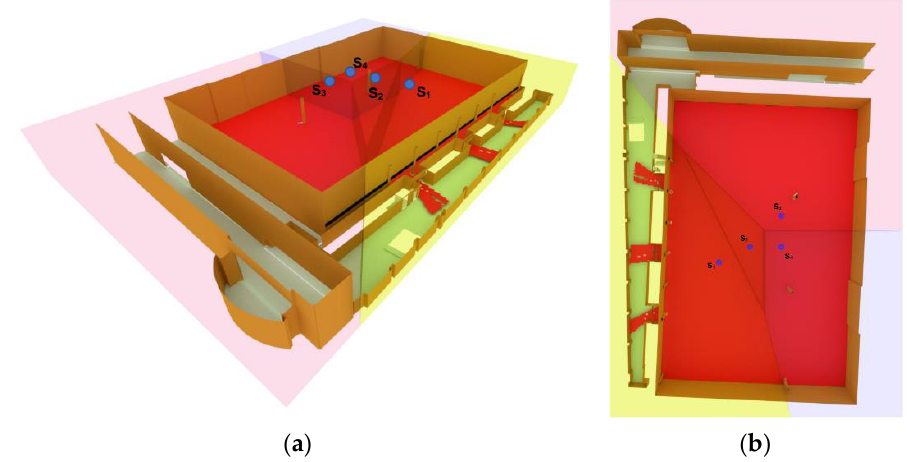
Figure 9. Initial position of cameras in the main hall ( a ) side view and ( b ) top view.